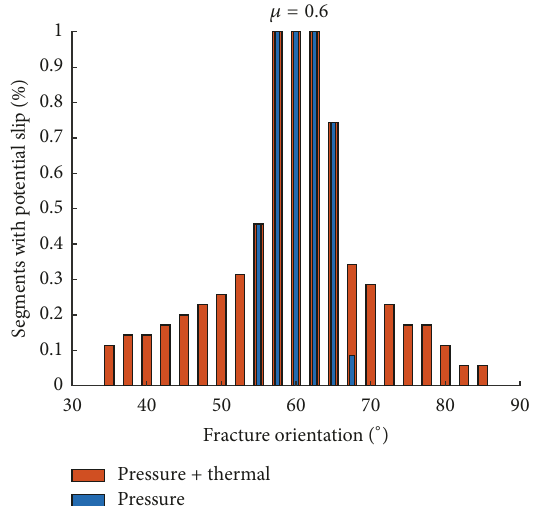
Figure 12: Failure potential for rotated fractures due to thermal stress in a bar diagram. It shows the percentage of fracture segments eligible for slip. Again, failure occurs only in a narrow range of orientations with the selected injection pressure. After 10 days of injection, thermal stress leads to possible slip in a wide range of